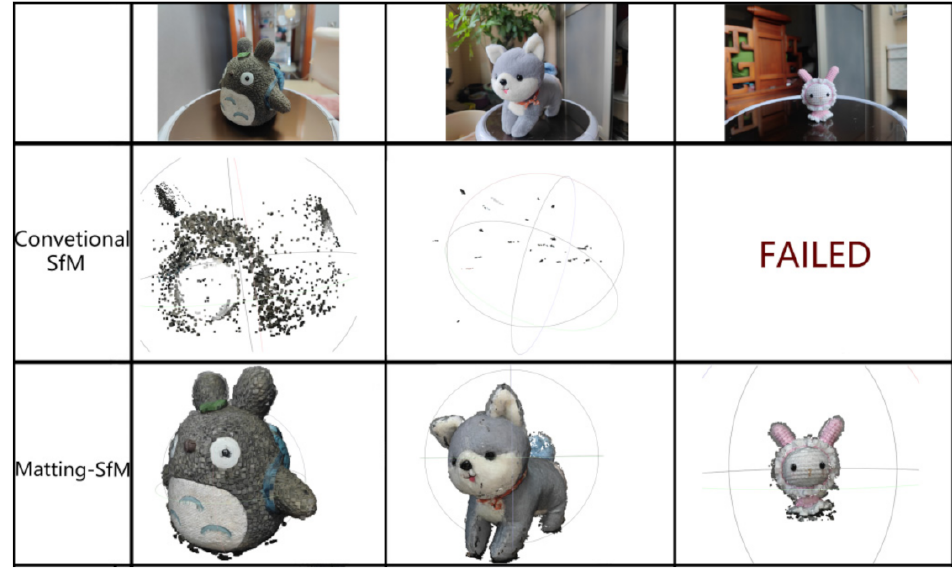
Figure 25. More objects used to test the performance of